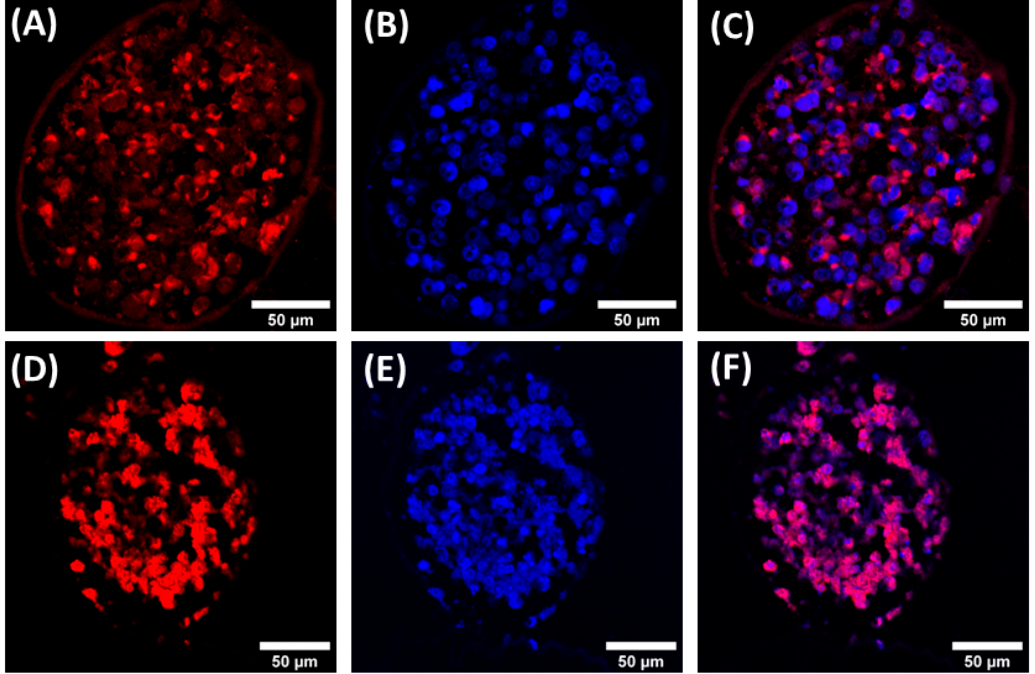
Figure 6. Confocal fluorescence images of Hela spheroids. E-cadherin immunolocalization (red, antibody conjugated with AlexaFluor 568) and nuclei staining (blue, DAPI) at 11 ( A – C ) and 18 ( D – F ) days of culturing. Colocalization by merging of the two channels at 11 ( C ) and 18 ( F ) days of culture.